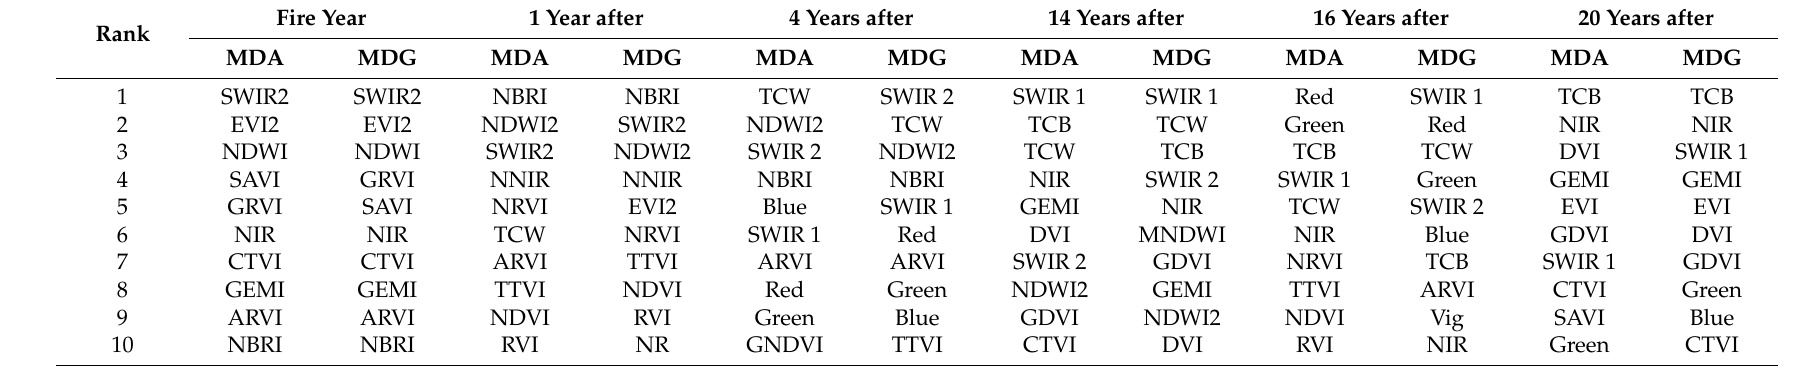
Table 2. The variable ranks obtained from third-round RF-VIMP for all observation